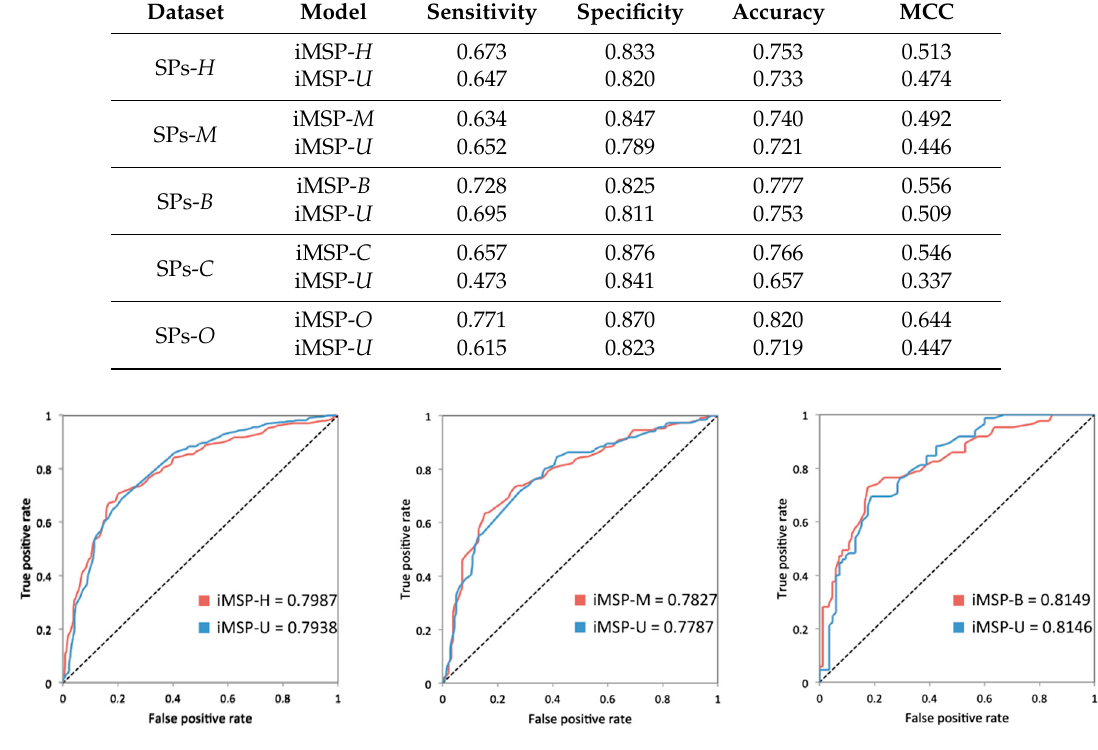
Table 4. Comparison between species-specific and universal schemes on different species of training datasets over five-fold cross-validation.